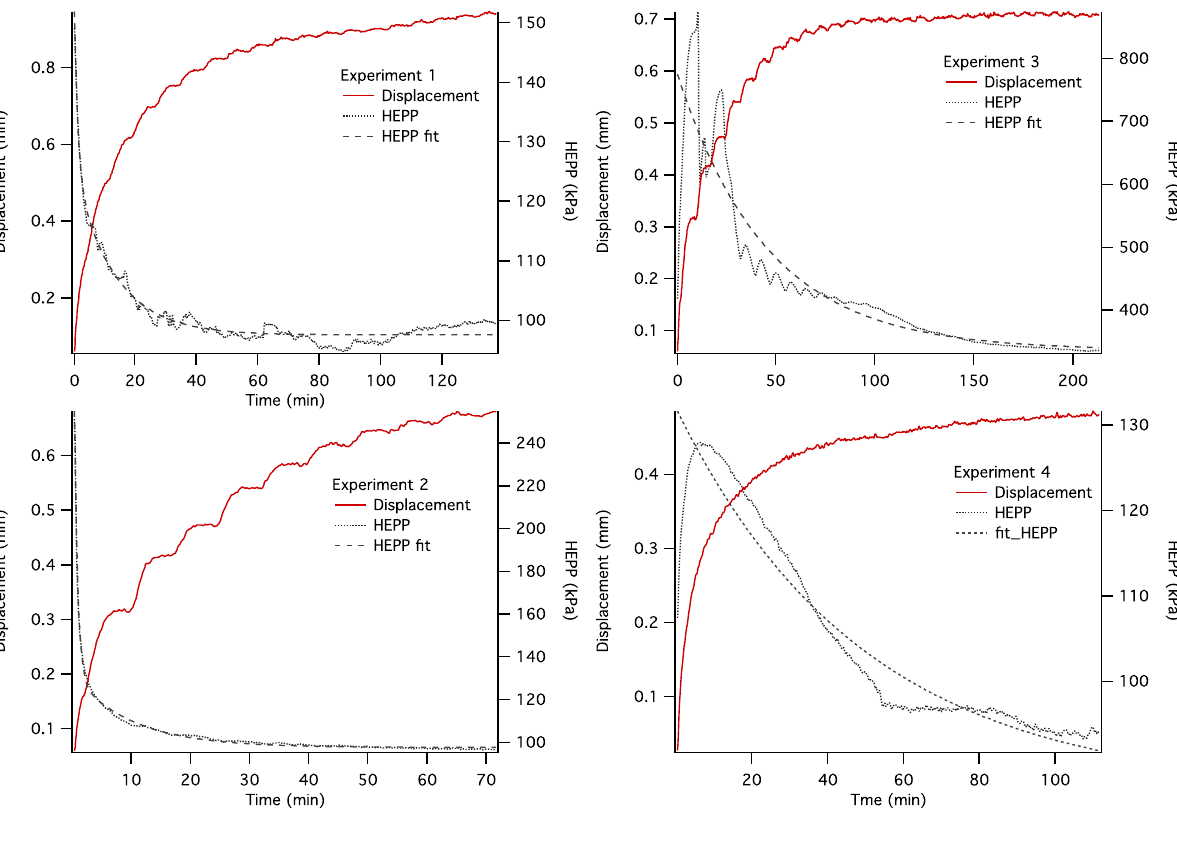
Figure 5. Unconstrained consolidation curves of the four articular cartilage samples showing HEPP curves (black) and the corresponding compressive displacement vs.